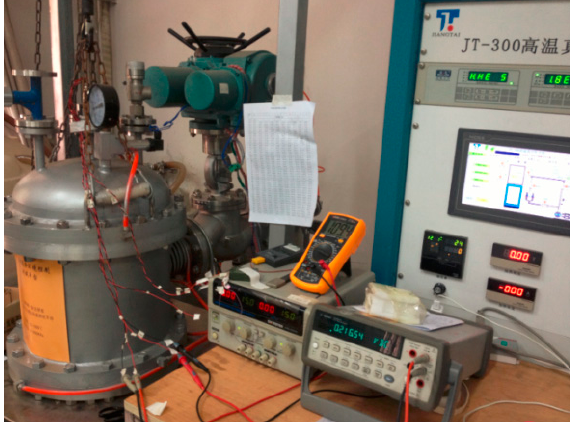
Figure 7. High-temperature and pressure calibration device developed by the authors.